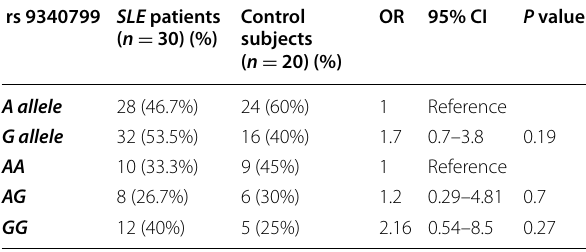
Data are represented as number (%) Data were analyzed using the odds ratio (OR) and 95% CI confidence interval.